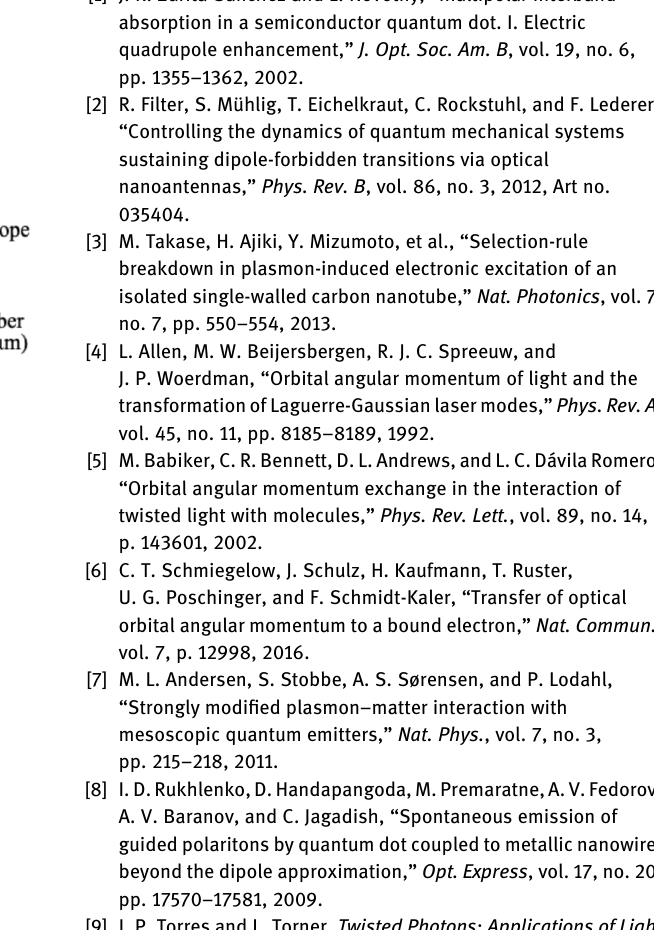
Figure 9: Configuration of the transmission spectroscopy measurement